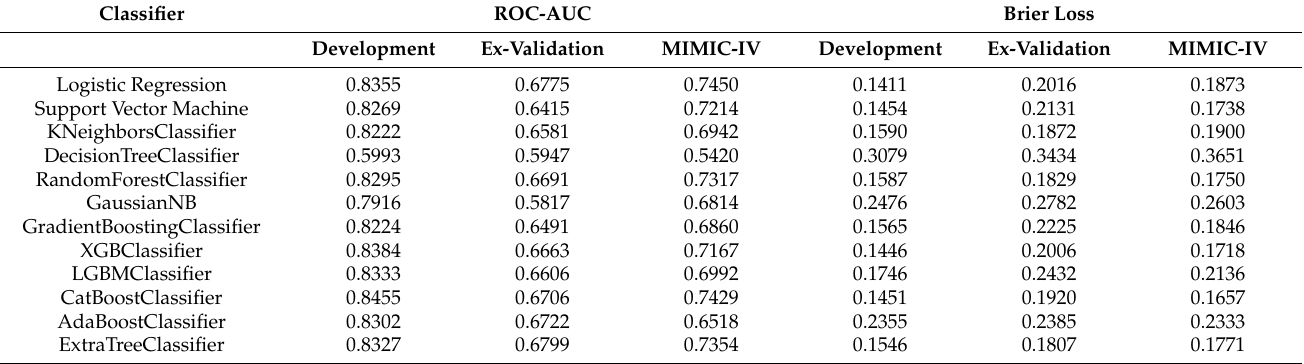
Figure 2. ( A ) The ROC-AUC of logistic regression and eleven machine learning algorithms in the development dataset. ( B ) The ROC-AUC of logistic regression and eleven machine learning algorithms in the validation dataset. ( C ) The ROC-AUC of logistic regression and eleven machine learning algorithms in the MIMIC-IV dataset. ( D ) The PR-AUC of logistic regression and eleven machine learning algorithms in the development dataset. ( E ) The PR-AUC of logistic regression and eleven machine learning algorithms in the validation dataset. ( F ) The PR-AUC of logistic regression and eleven machine learning algorithms in the MIMIC-IV dataset. ( G ) The calibration curve of logistic regression and eleven machine learning algorithms in the development dataset. ( H ) The PR-AUC of logistic regression and eleven machine learning algorithms in the validation dataset. ( I ) The PR-AUC of logistic regression and eleven machine learning algorithms in the validation dataset. Table 2. The ROC-AUC and brier loss score for the development, validation and MIMI-IV